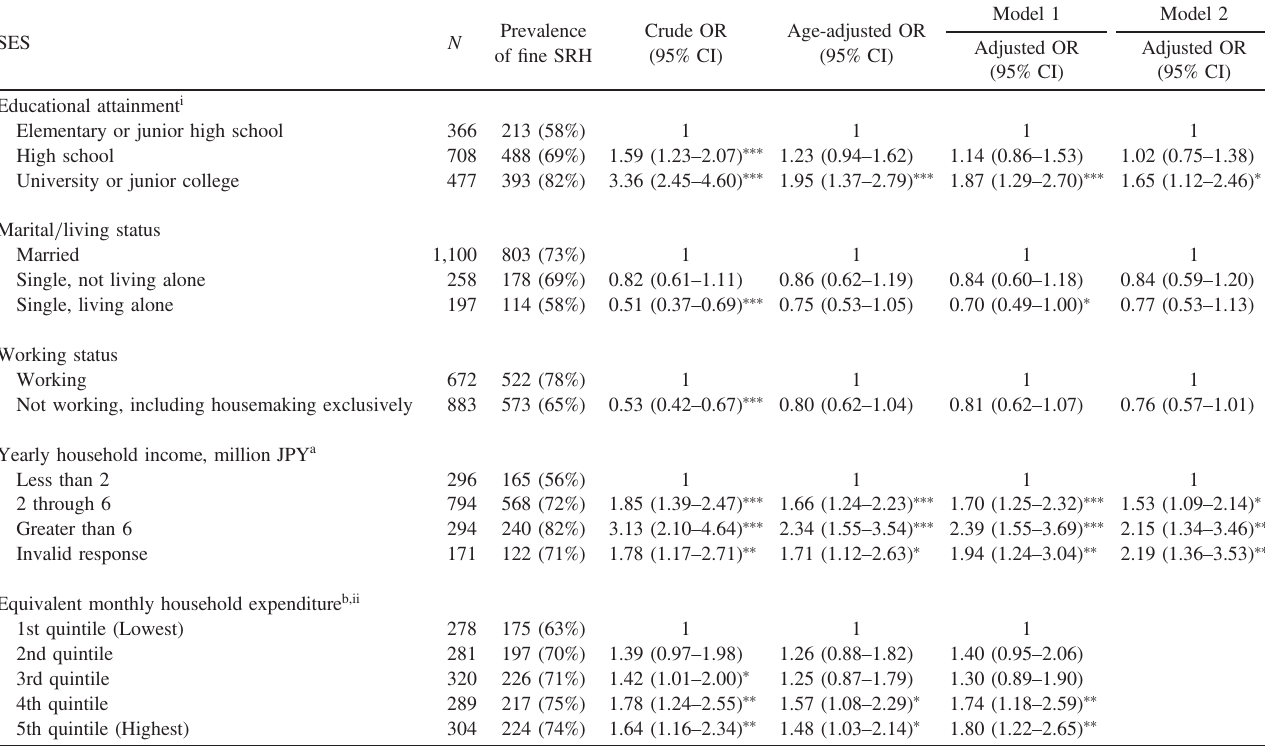
Table 3. Relationships among socioeconomic status and fi ne self-rated health in women ( n = 1,555): NIPPON DATA2010